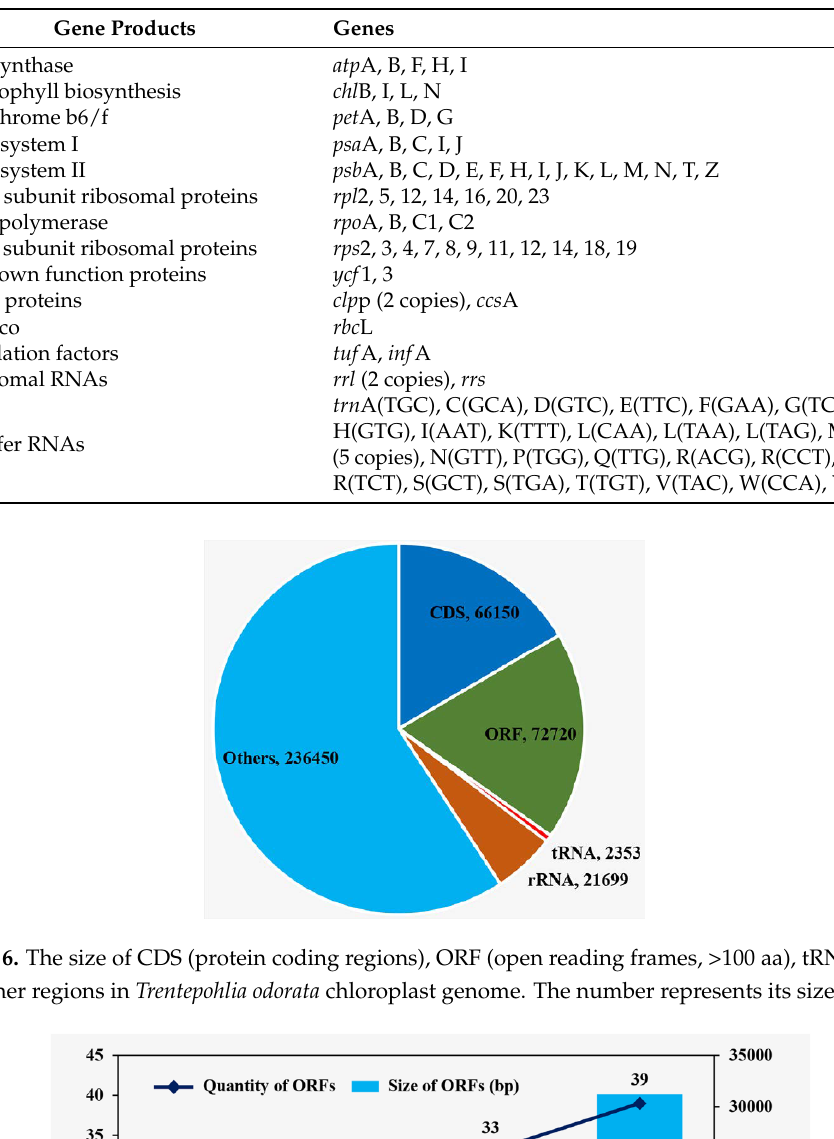
Table 1. Genes encoded by Trentepohlia odorata chloroplast genome.